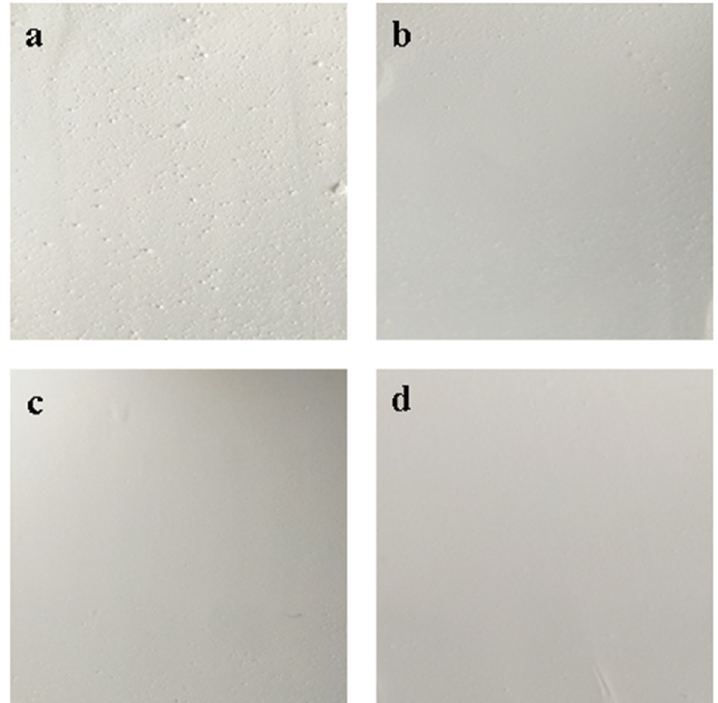
Figure 4. BaSO 4 bifunctional sheets prepared with different mixing times: ( a ) 0.5 h; ( b ) 1 h; ( c ) 1.5 h; ( d ) 2 h.